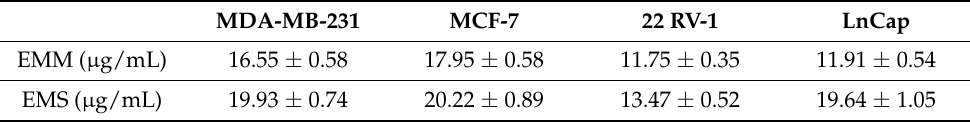
Figure 5. Antiproliferative effect of methanol extracts obtained by maceration (EMM) and Soxhlet (EMS) from Hispanica bark root in MCF-7 ( a ) , MDA-MB-231 ( b ) , 22RV1 ( c ) , LnCap ( d ) cell lines of 72 h post-treatment (concentrations ranging from 4.68 µg/mL to 150 µg/mL for both extracts). ( e ) : Effect of mitomycine used as drug reference towrds all cell lines. Table 4. IC 50 values of B. hispanica extracts in MDA MB-231, MCF7, LnCap, and 22rv cell